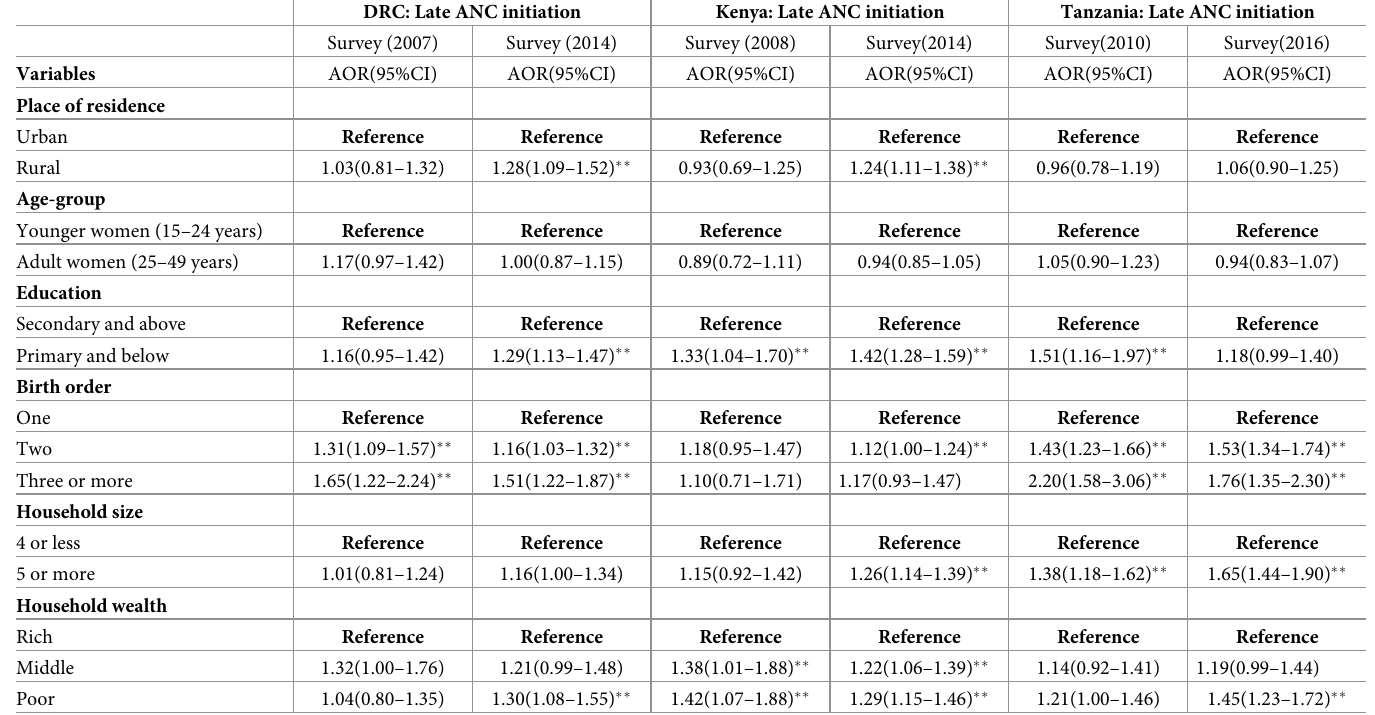
Table 4. Determinants of late ANC initiation in the DRC, Kenya and